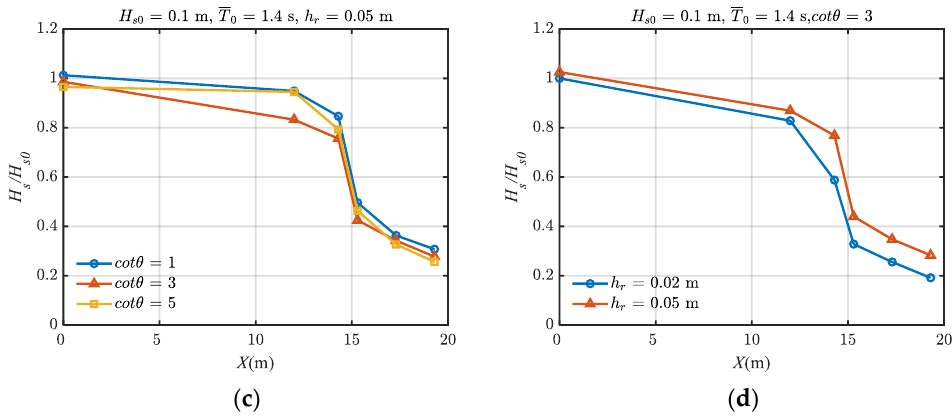
Figure 5. Irregular wave height transformation on the reef topography for different cases: ( a ) H s 0 ; ( b ) T 0 ; ( c ) cot θ ; ( d ) h r